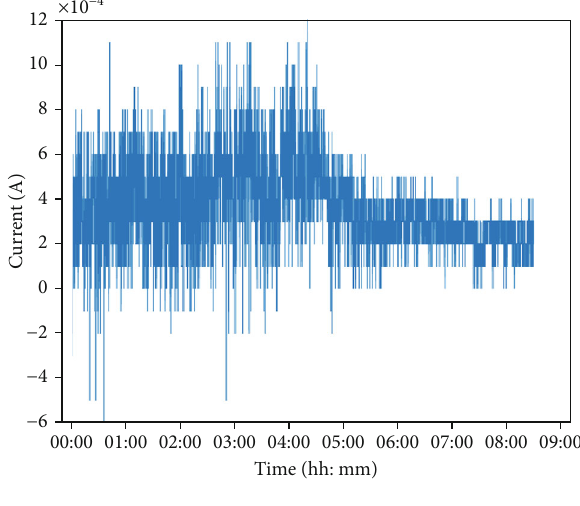
Figure 19: Current of the solar